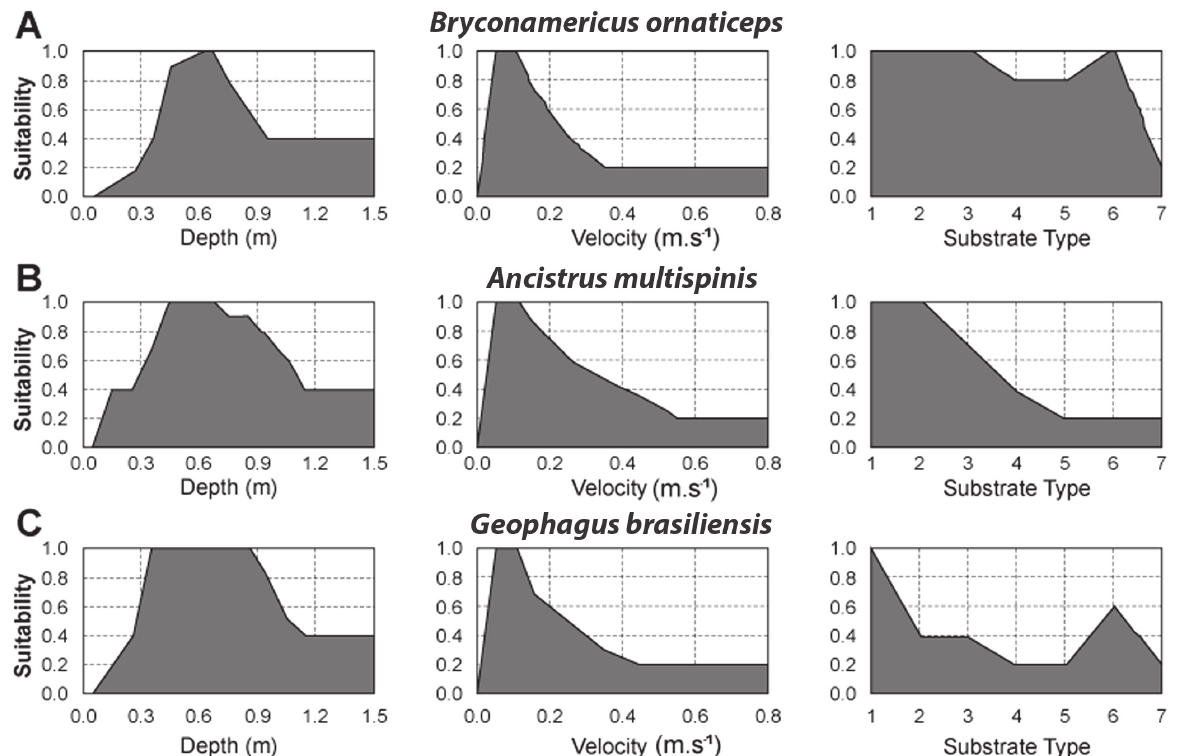
Fig. 4. Habitat suitability curves for depth (m), mean water column velocity (m/s) and type of substrate for the three fish species in the riacho São Pedro. Substrate types are; 1- large boulder, 2- boulder, 3- cobble, 4- gravel, 5- fine gravel, 6- sand and 7-